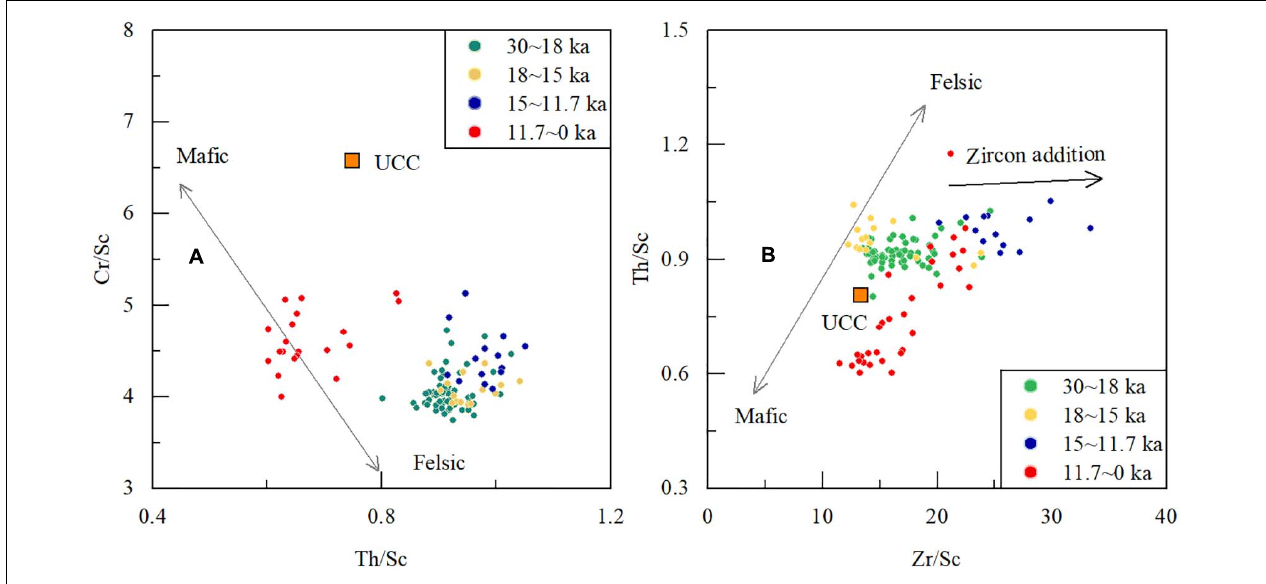
FIGURE 3 | Evaluation of sedimentary provenance and sorting by plots of (A) Th/Sc-Cr/Sc and (B)